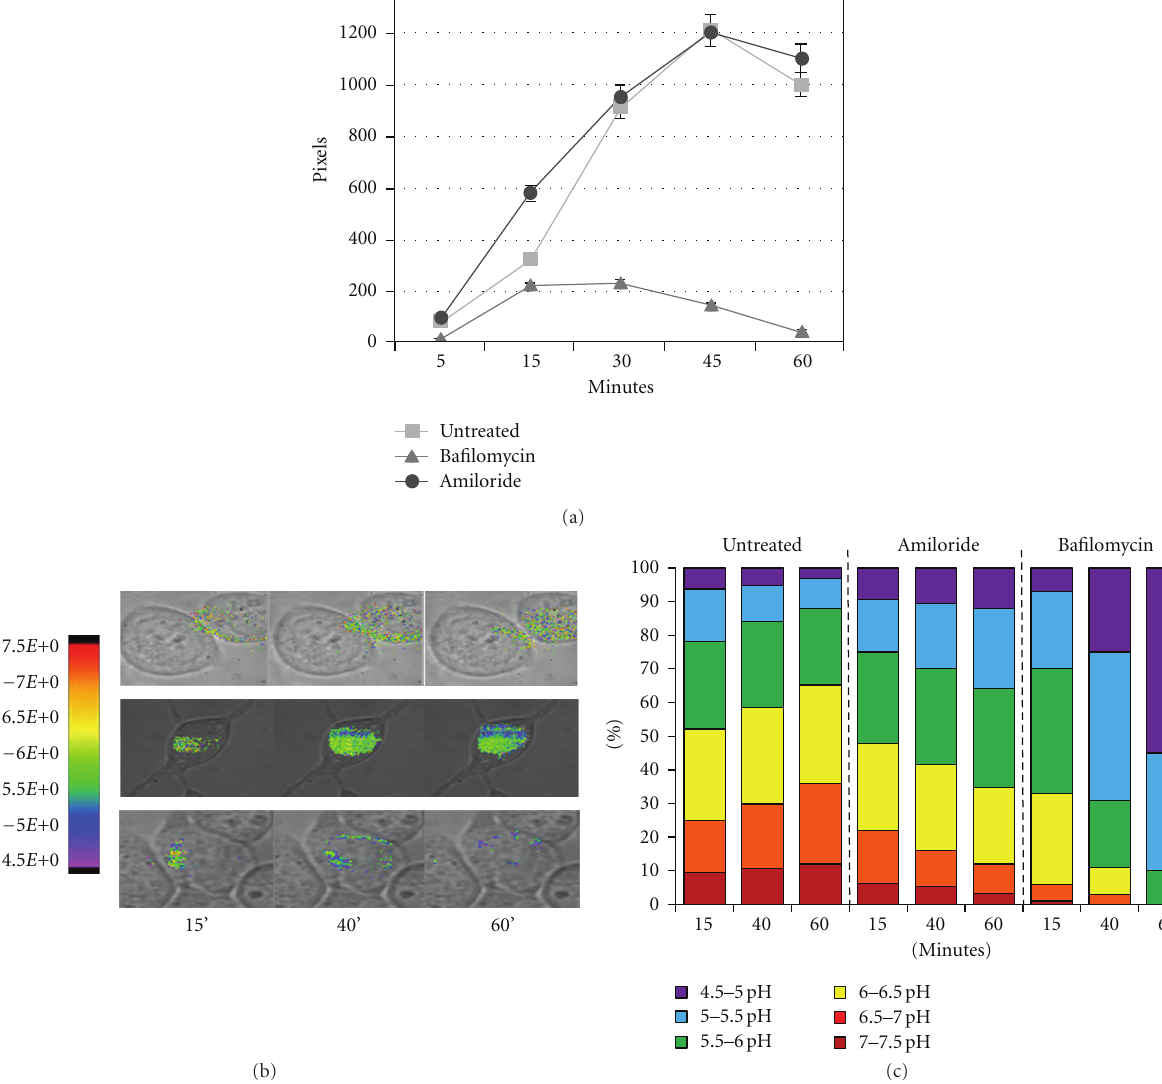
Figure 10: Pharmacologic e ff ects on nanosensors at 25 ◦ C. Cells incubated at 25 ◦ C with the addition of bafilomycin or amiloride. Cells are incubated at 25 ◦ C with simultaneous addition of nanosensors and respective drug. (a) Is a demonstration of total nanosensor number displayed as pixels, averaged from three individual cells. (b) Whole-cell pH image maps of cells incubated at 25 ◦ C with the addition of nanosensors alone (untreated), with bafilomycin, or amiloride, followed by imaging at the corresponding time points below. (c) Bar graph demonstration of the percentage of nanosensors averaged from three cells, from the whole, that fall into each pH grouping in cells that are either untreated and incubated at 25 ◦ C, or treated with drug and incubated at 25 ◦ C. Reprinted with permission from Nowak-Lovato et al. [11] (copyright 2010